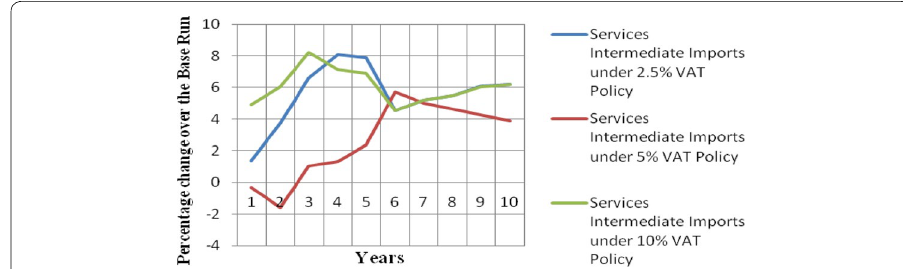
Fig. 43 Changes in services intermediate imports under varying VAT rates